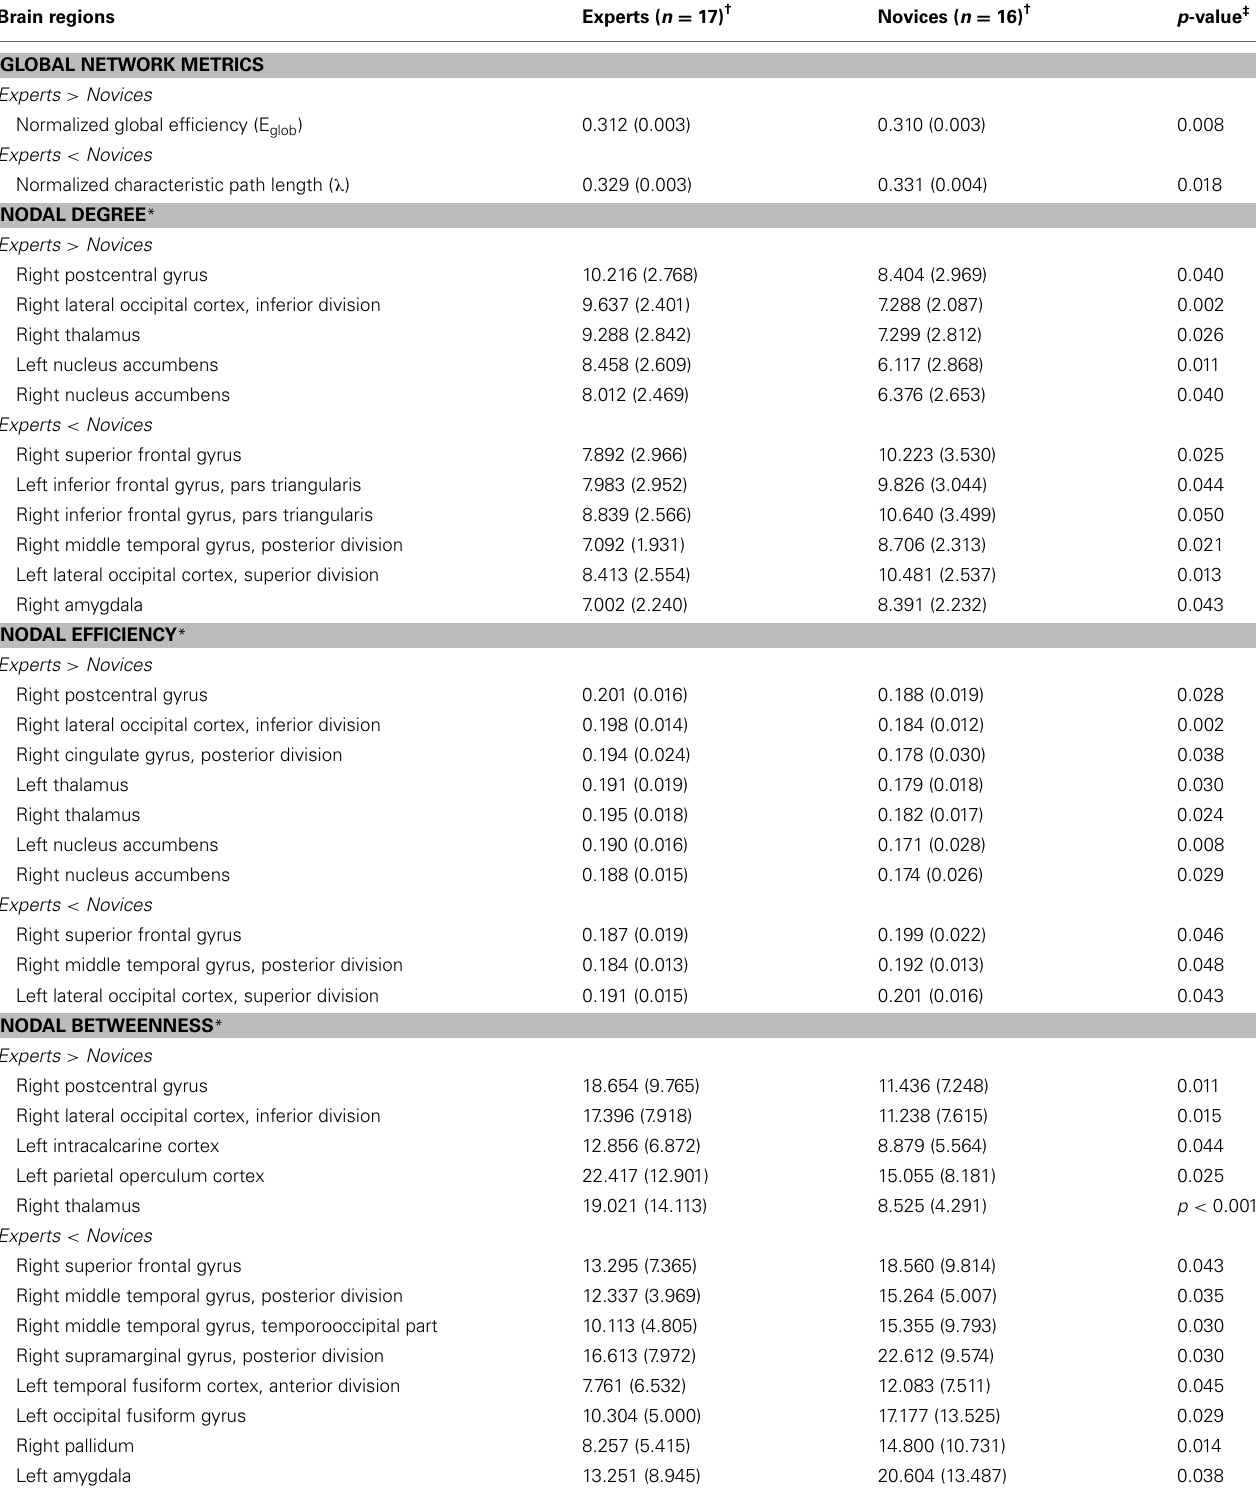
Table 4 | Regions showing significant differences in nodal centrality metrics between experts and novices. Brain